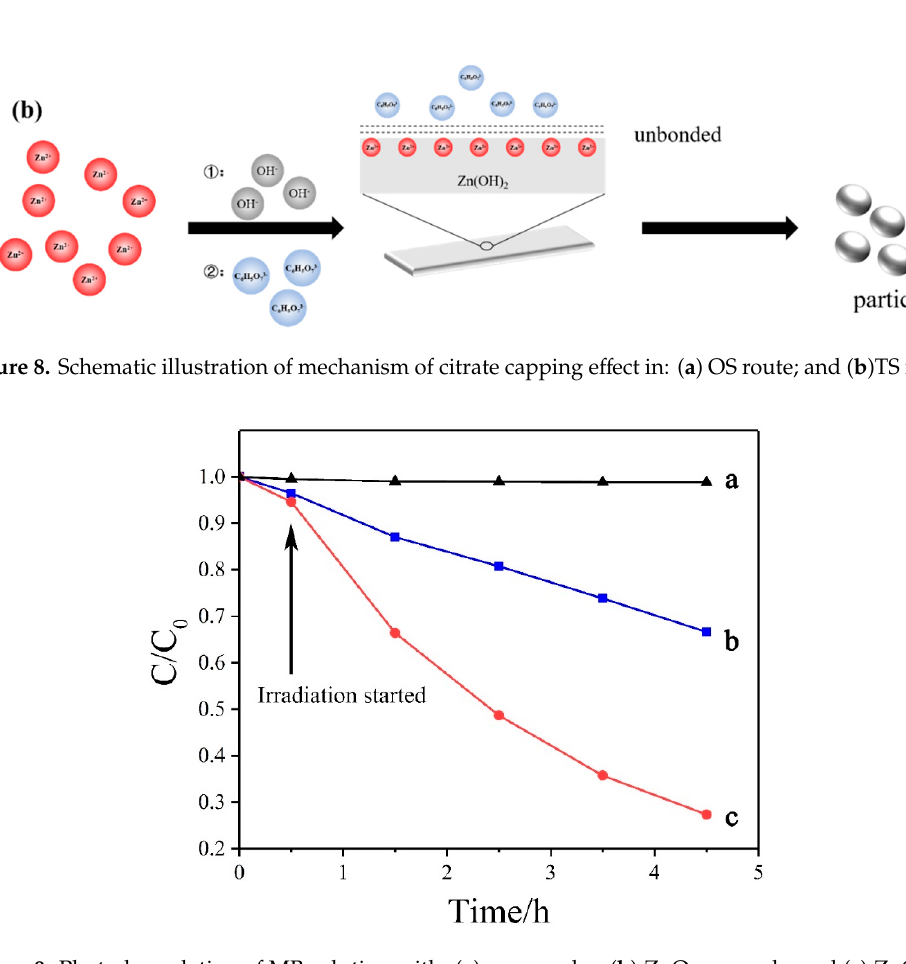
Figure 9. Photodegradation of MB solution with: ( a ) no samples; ( b ) ZnO nanorods; and ( c )